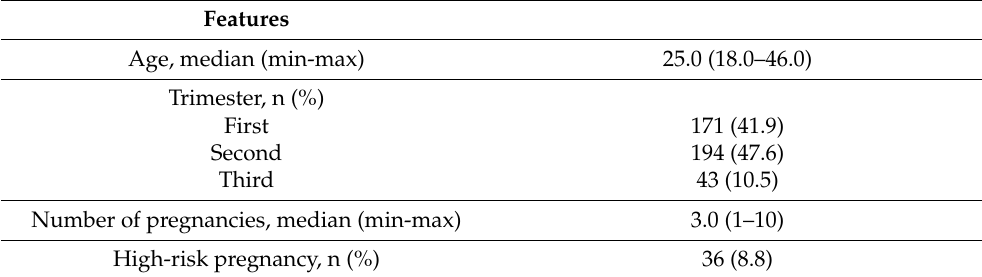
Table 1. Age and pregnancy-related features of pregnant women (n =